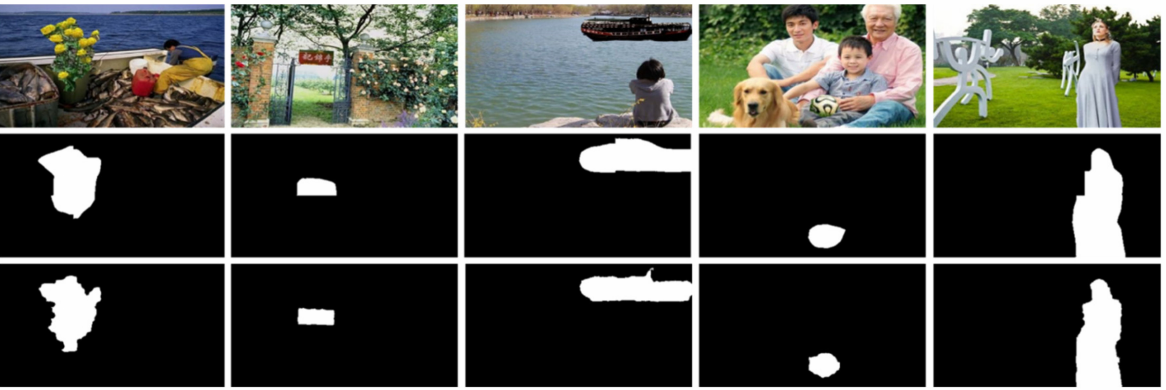
Figure 3. Image examples. Top row: original images; second row: binary probability maps predicted by our model; third row: the ground truth of tampered area.